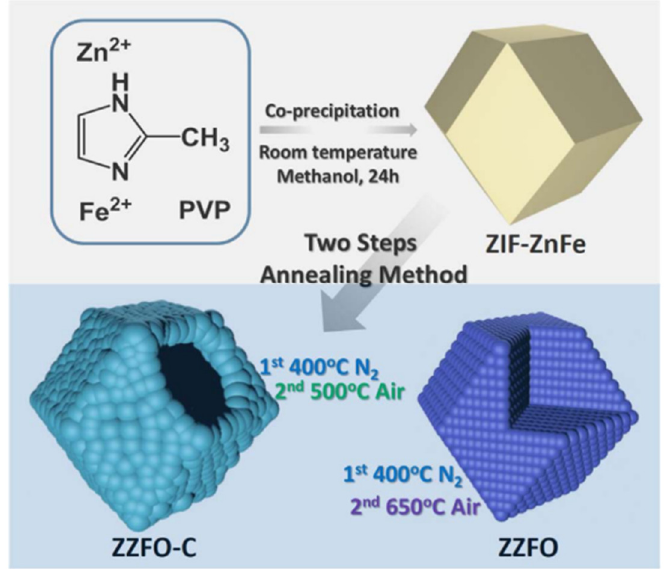
Figure 7. Scheme of synthesis process of ZZFO-C and ZZFO. Reprinted with permission from [142]. Copyright 2017, Elsevier.